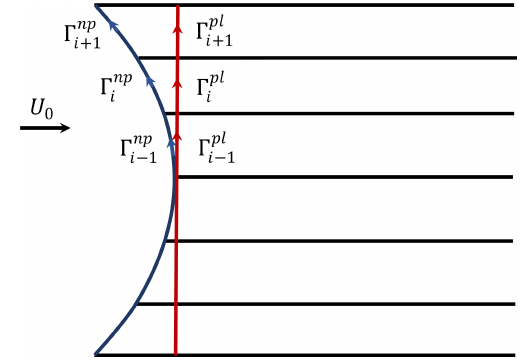
Figure 5. Side view of a part of the axisymmetric vortex system of the planar rotor. The bound vorticity and trailed vorticity are high- lighted. The two points of interest are marked with × and + , which are just inside and outside the section i . The two circular contours of C 1 and C 2 pass through the two points of interest